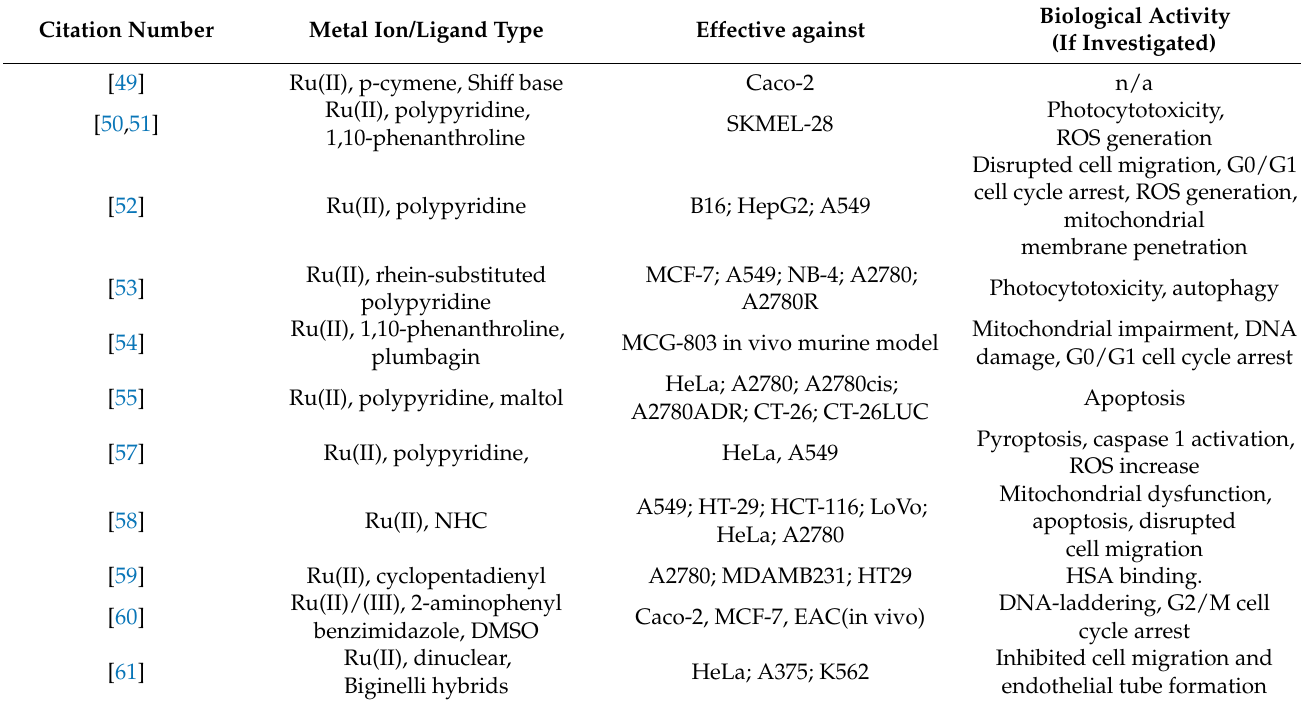
Table 2. Summary of the ruthenium complexes